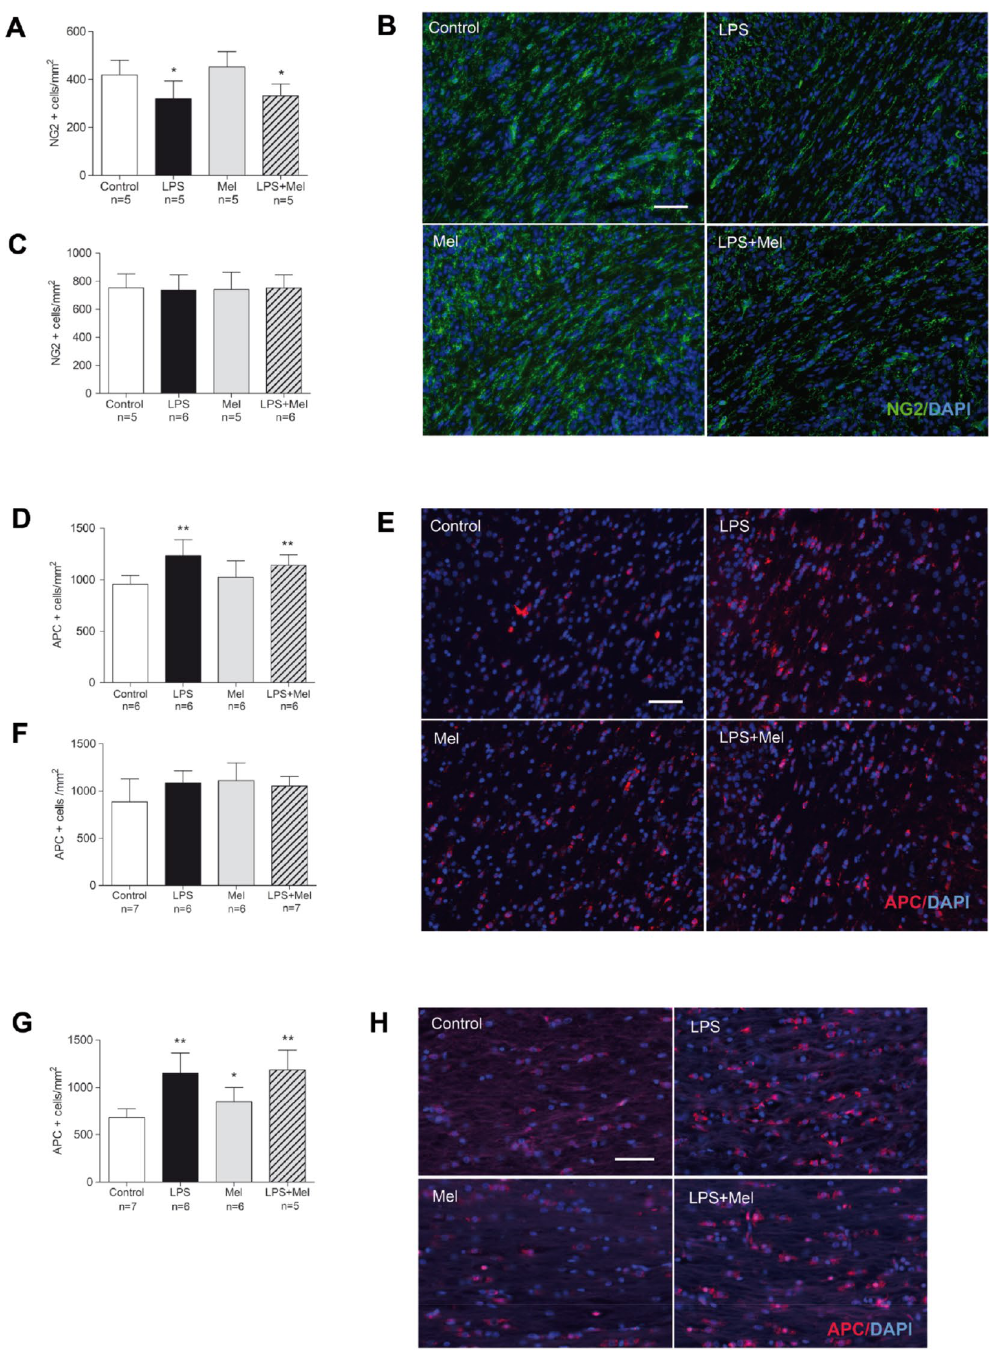
Figure 4. Melatonin failed to prevent the oligodendrocyte (OL) lineage alterations induced by the prenatal LPS challenge. Early OL populations stained by NG2 antibody were assessed within the external capsule in each experimental group on PND1 ( A ) and on PND7 brain sections ( C ), respectively. Photomicrographs of the NG2 immunofluorescence (green staining) coupled with DAPI counterstained (blue staining) within the external capsule at PND1 are reported in each experimental group (magnification 20, scale bar = 50 µm) ( B ). Mature OLs were stained by APC antibody ( E , H ). Photomicrographs of the APC immunostaining (red staining) coupled with DAPI counterstained (blue staining) within the external capsule at PND7 (magnification 20, scale bar = 50 µm) ( E ) and within the corpus callosum at PND21 (magnification 20, scale bar = 50 µm) ( H ) are reported. The APC-positive cells were counted within the external capsule of the PND7 ( D ) and PND21 ( F ) brains and within the corpus callosum at PND21 ( G ) in each experimental group. White, black, grey and hatched grey bars represented the Control, the liposaccharide portion of the E. coli membrane (LPS), the melatonin (Mel) and the LPS + Mel groups, respectively. Results are expressed as the mean of positive cells/mm 2 ± standard deviation. Statistical analysis: One-Way- ANOVA test was performed associated with Bonferroni post-test, * p < 0.05 and ** p < 0.01 in comparison with the Control